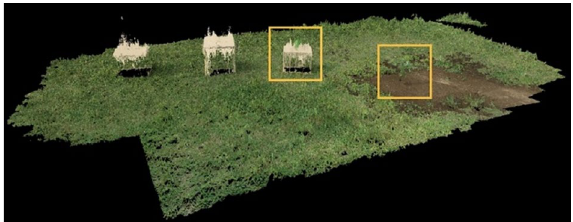
Figure 10. 3D reconstruction through